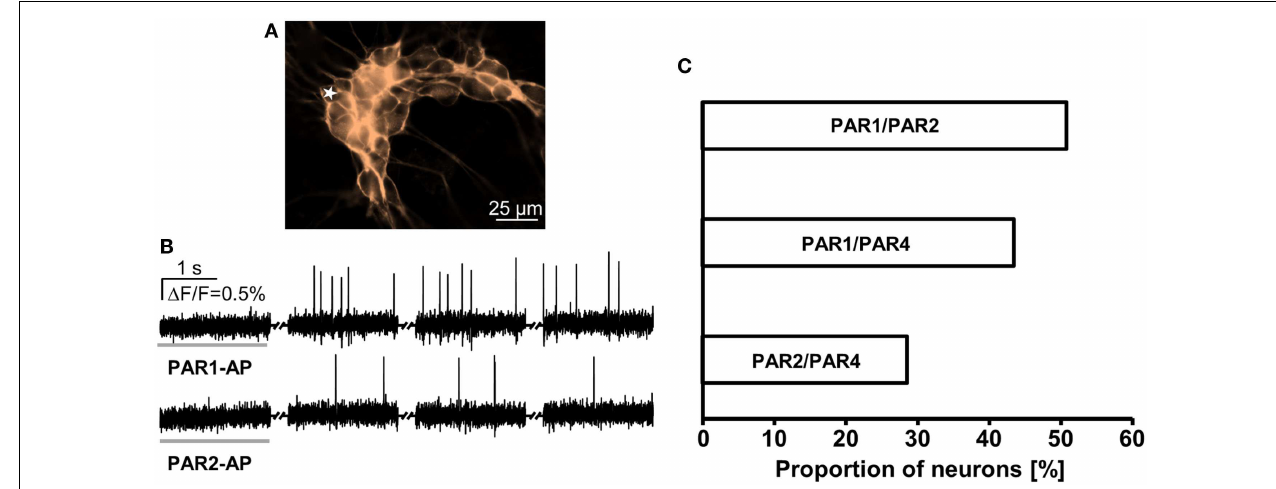
2s long recording periods with 5–6s intervals in between (indicated by the symbol between the traces). Every peak represents an action potential. (C) Pairwise application of PAR-APs revealed functional coexpression patterns. Proportions of neurons responding to two PAR-APs are expressed relative to the proportion of neurons responding to any PAR-AP in that particular set of experiment